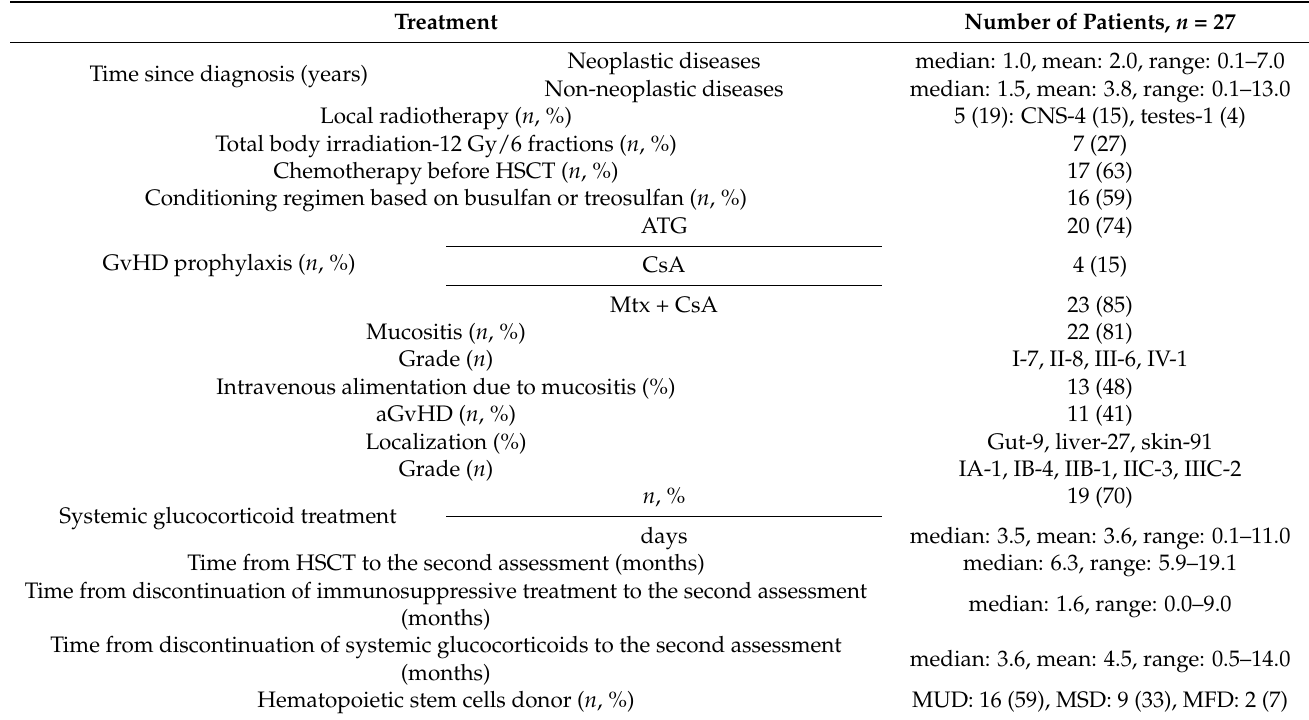
Table 2. The summary of therapeutic interventions in children referred for allogeneic